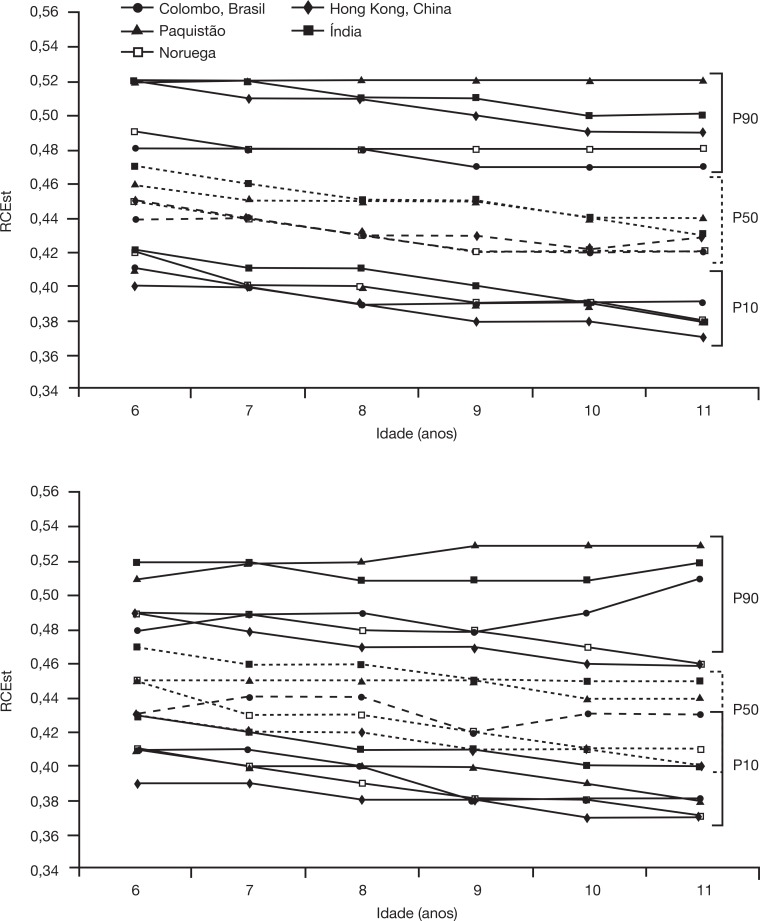
Comparação dos valores de percentis 10, 50, e 90 para razão
cintura-altura entre crianças de Colombo e crianças de outros
países.